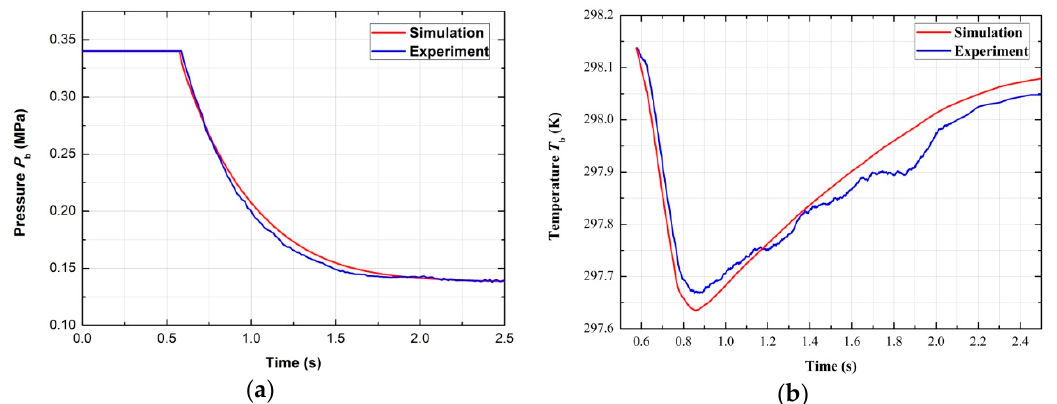
Figure 23. Curves of pressure and temperature when chamber b is discharging: ( a ) Pressure curves; ( b ) Temperature curves.